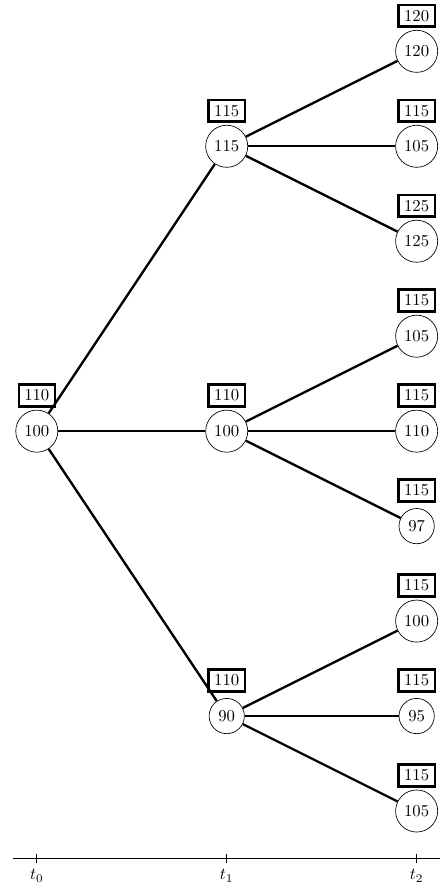
Figure 2. An example of the price tree . Underlying’s price is marked with circles and corresponding maximums are marked with